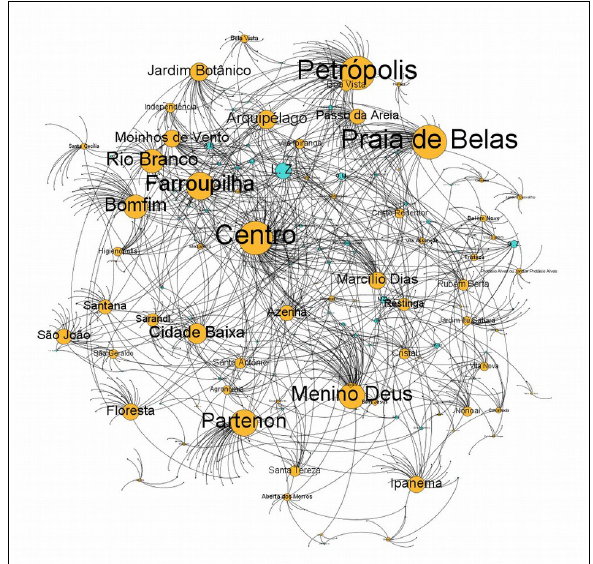
Figure 4. Two-mode network: volunteers (PortoAlegre.cc) X districts (Porto Alegre city)